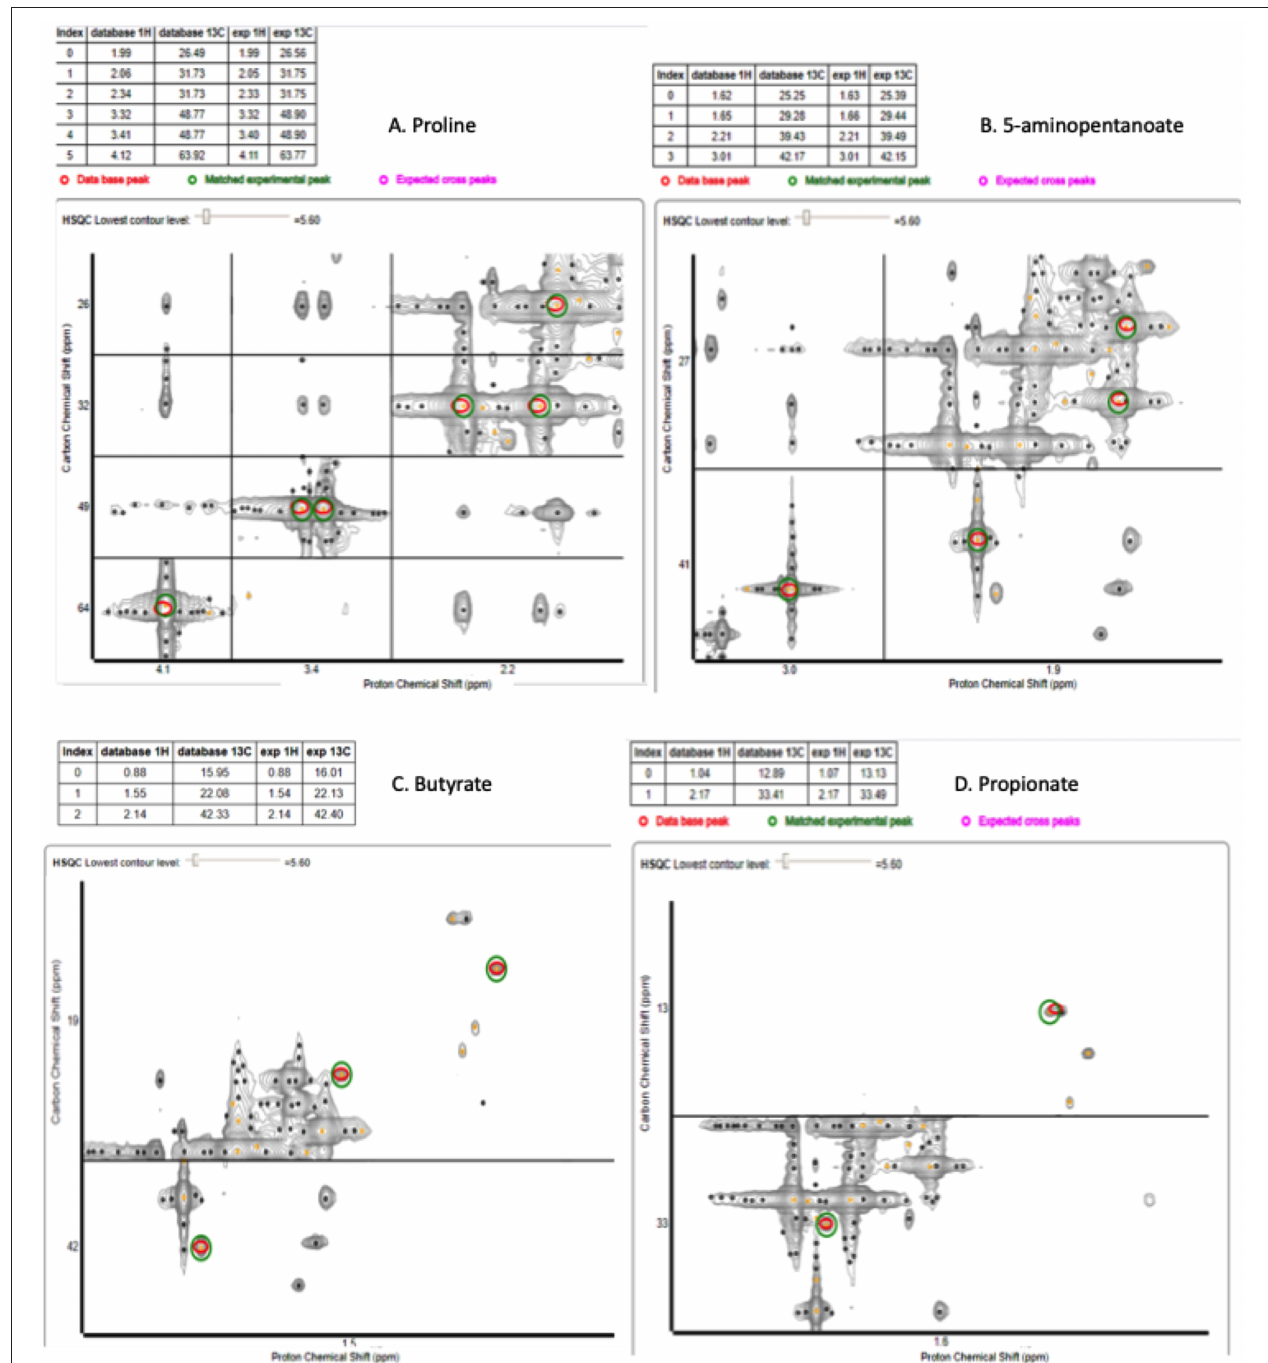
FIGURE 6 | 2D HSCQ NMR spectra for one day 7 10mM C 13 -labeled proline supplemented biofilm spent saliva sample. The red circles identify the peaks within the database, and the green circles identify the matched experimental peak from the sample. The experimental peaks match all database peaks for proline (A) , 5-aminopentanoate (B) , butyrate (C) , and propionate (D)